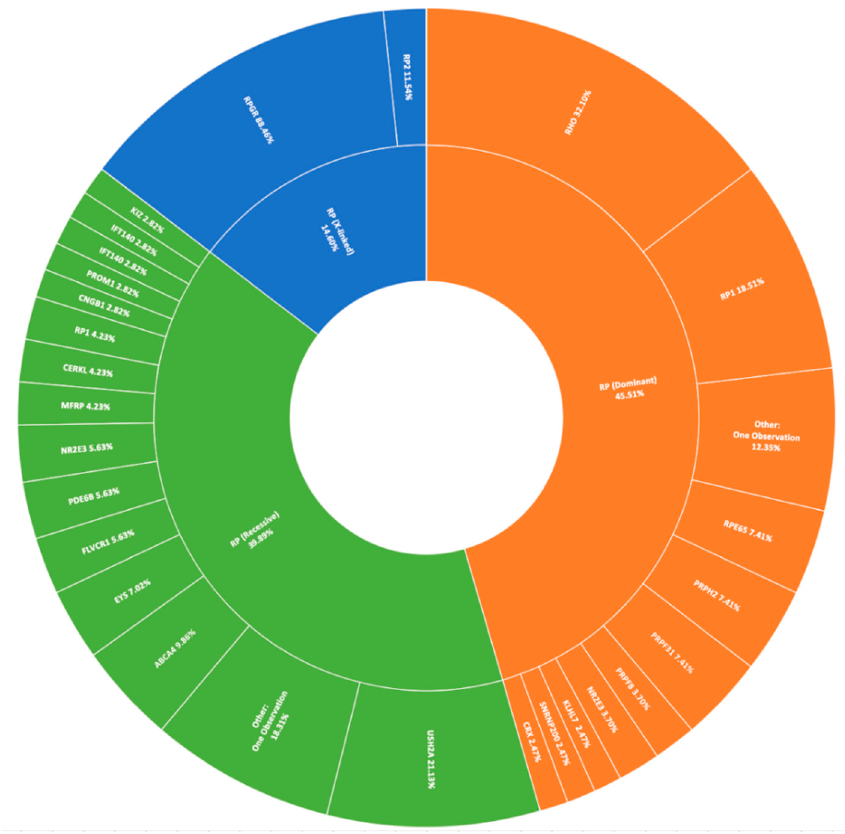
Figure 3. A summary of the genetic architecture of retinitis pigmentosa (RP) in Target 5000 participants (Table S4).